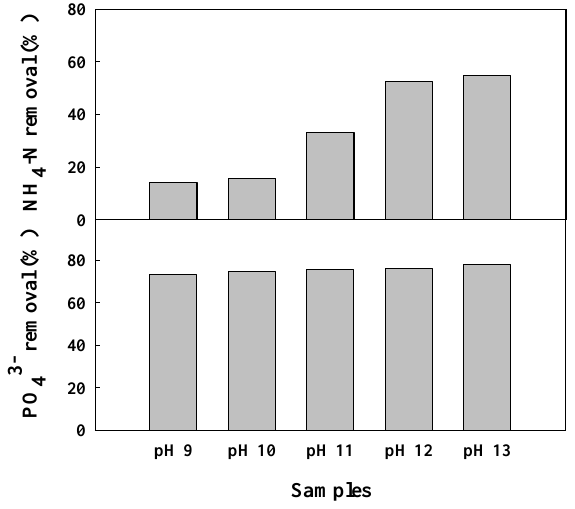
Figure 1. Effect of the initial pH on the struvite crystallization of anaerobic digestive fluid of swine